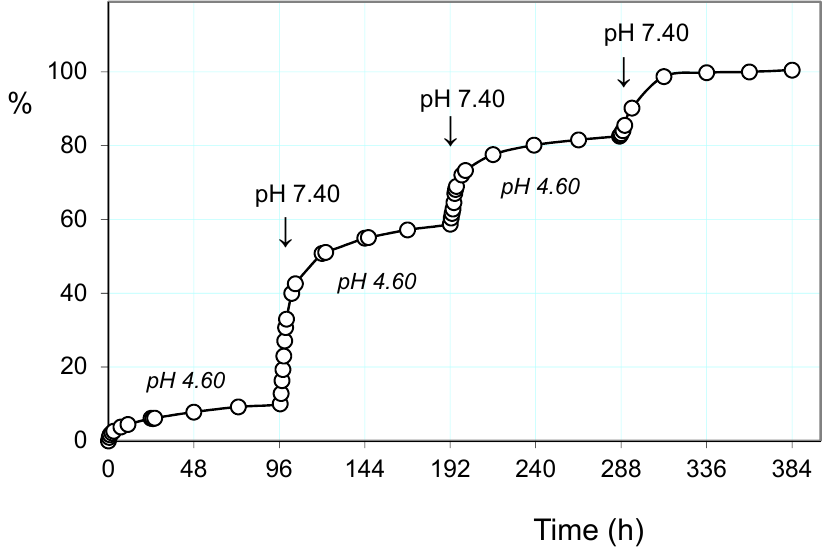
Figure 6. Paroxetine release (%) from the hydrogel AVA-5 on pulsed variation of buffer solutions (PBS, pH 7.40; acetate, pH 4.60) at 25 °C.